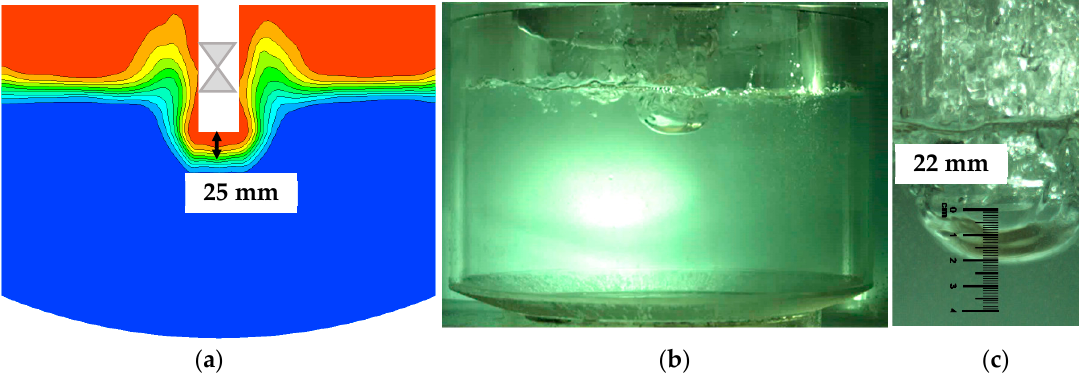
Figure 3. Comparison of gas-liquid distribution between experimental the simulated results. ( a ) Simulated result, ( b ) experimental result and ( c ) measuring of gas penetrated depth.